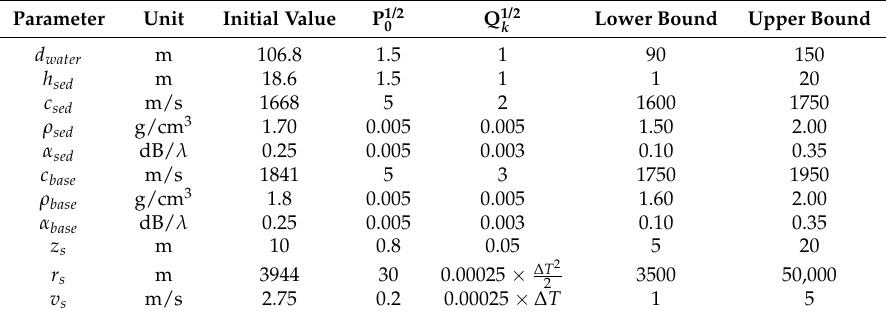
Table 3. Geoacoustic environment parameters used in the shallow-water